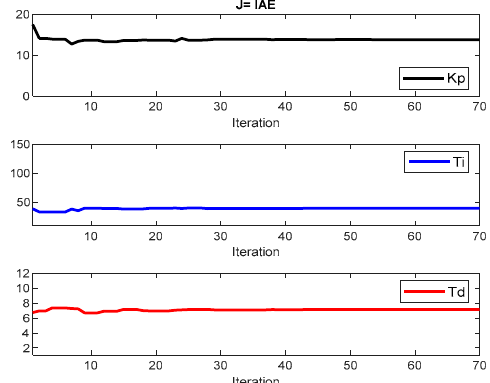
Figure 10. PSO evolution of the PID controller gains resulting in the final values used in the system response of Figure 9.